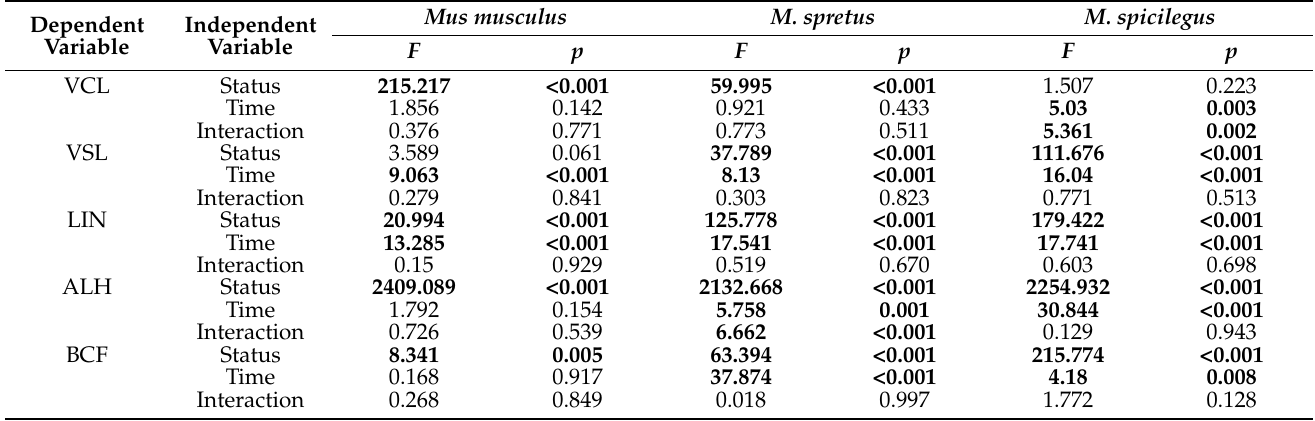
Table 3. Effect of time of incubation (“Time”), sperm status (“Status”: hyperactivated vs. non- hyperactivated), and interactions between time and status (“Interaction”) on kinetic parameters in three mouse species ( M. musculus , M., spretus , and M. spicilegus ) incubated under capacitating conditions (mT-BH medium). Values F and p correspond to statistical analyses of repeated measure ANOVAs. Individual was used as a random factor, and incubation conditions and time were used as fixed factors. Results in bold indicate significant differences ( p < 0.05) in statistical analyses. VCL: curvilinear velocity; VSL: straight-line velocity; LIN: linearity; ALH: amplitude of lateral head displacement; BCF: beat-cross